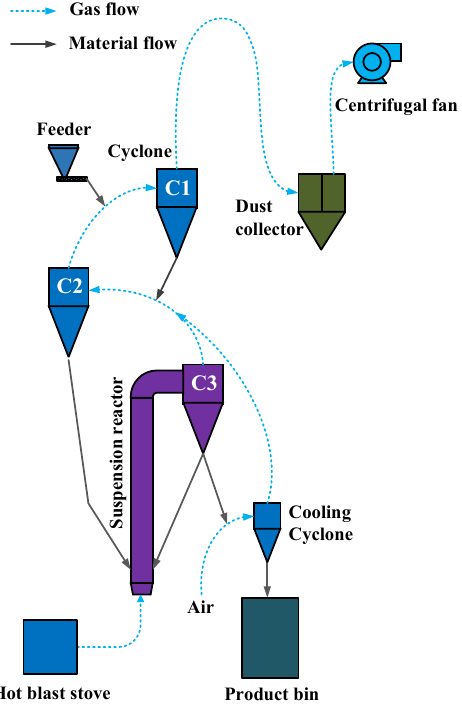
Figure 2. Schematic showing the suspension calcination pilot system.